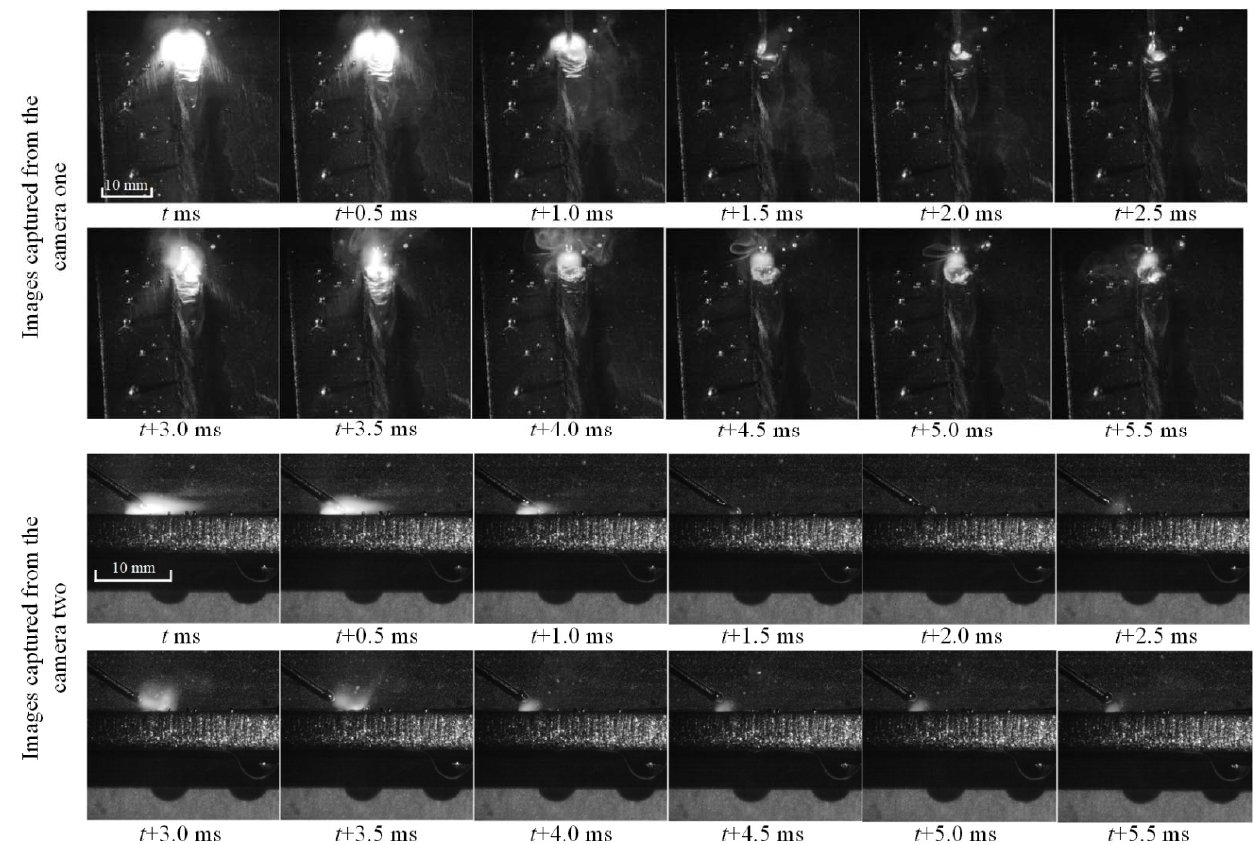
Figure 7. Visual phenomena of partial penetration (No.2) in laser ‐ MIG hybrid welding.